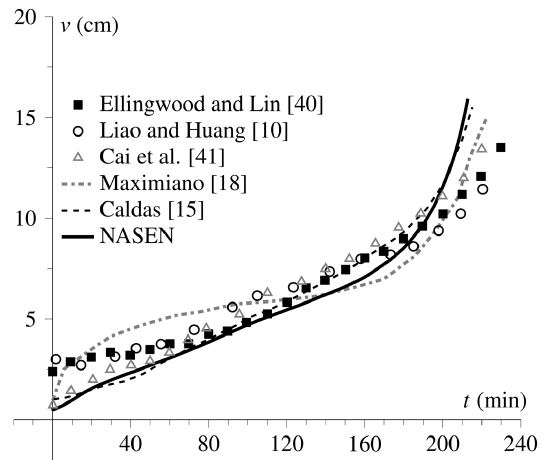
Figure 6. Vertical displacement versus time of heat exposure for reinforced concrete beam.